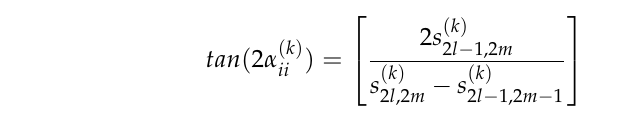
× M elements to obtain 2 2